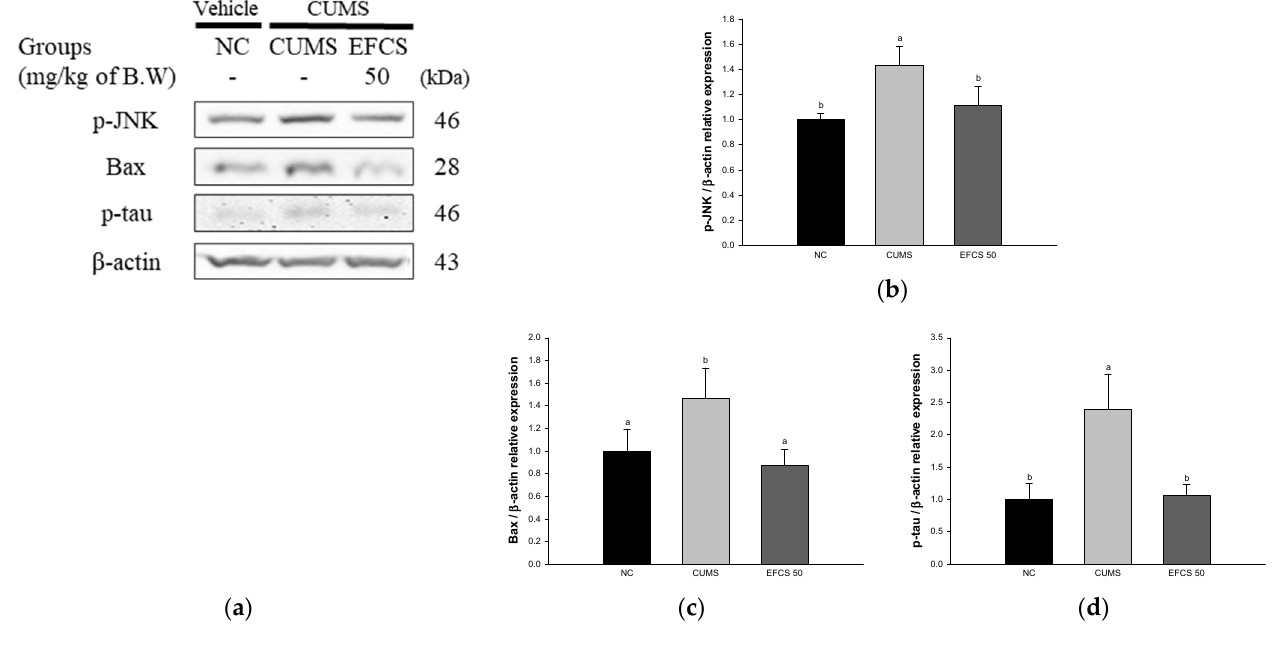
Figure 9. Effect of ethyl acetate fraction from Cedrela sinensis (EFCS) on CUMS-induced apoptosis pathway. Western blot images ( a ), protein expression levels of p-JNK ( b ), Bax ( c ), and p-tau ( d ) in brain tissues. Results shown are mean ± SD ( n = 3). Data are statistically considered at p < 0.05, and different lowercase letters indicate statistical significance. Means with the same letter are not significantly different.